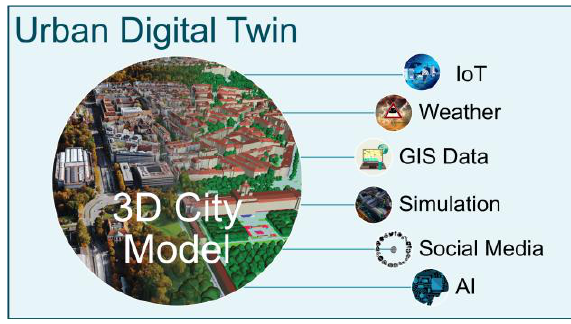
Figure 1 : From 3D City Model to an Urban Digital Twin